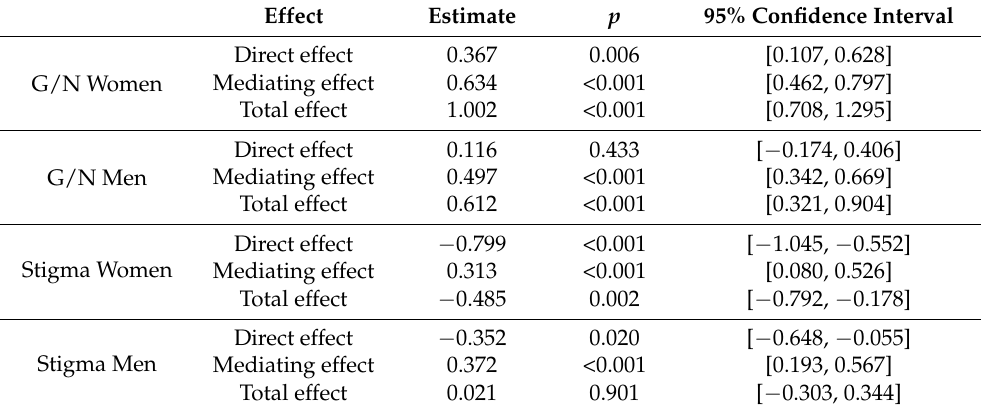
Table 6. Estimated mediating effect of suicidal ideation in the association between glorifica- tion/normalization and stigma toward suicide and suicide attempts in women and men. Age and education level were entered as covariates.